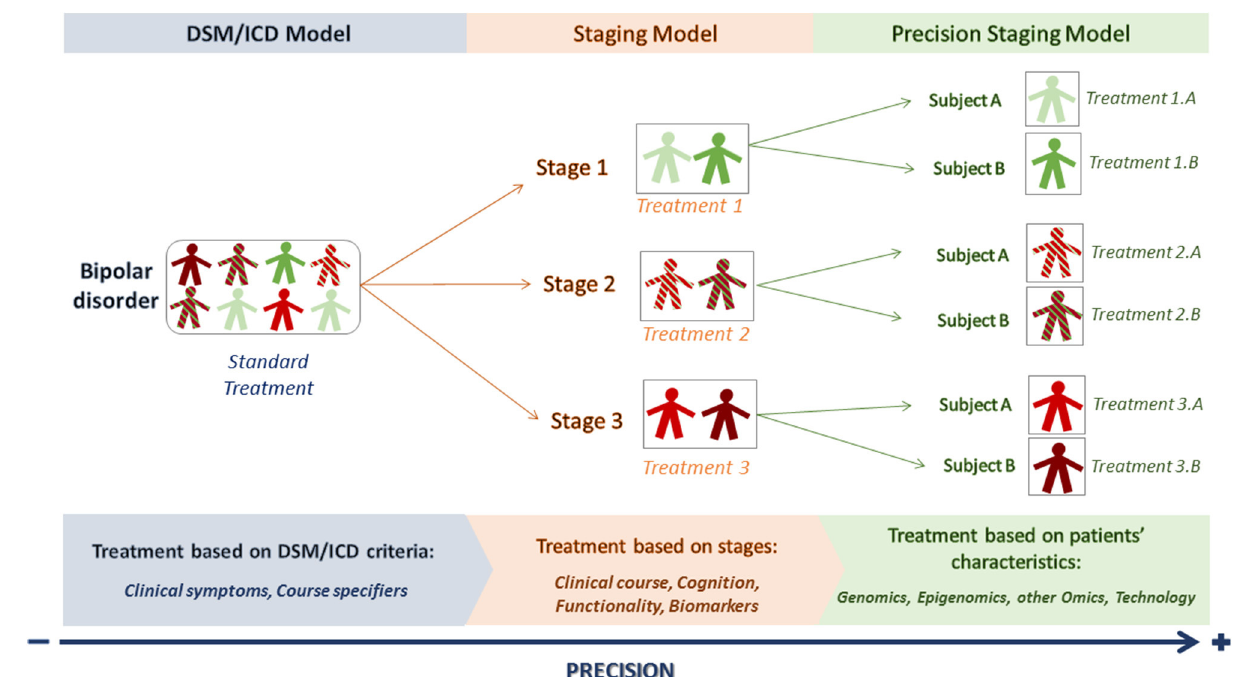
FIGURE 1 | From DSM/ICD to precision staging models. The DSM/ICD model classifies patients into particular conditions according to clinical-based criteria. DSM/ICD diagnosis can be refined by course specifiers. The staging model allows placing the patient in a particular stage according to the extent of illness progression, starting from at-risk stages (stage 1) to more chronic ones (stage 3). However, there can still be differences between patients within a particular stage. A precision staging model would then use the new advances on precision medicine to better characterize the patients and offer them a more personalized treatment.